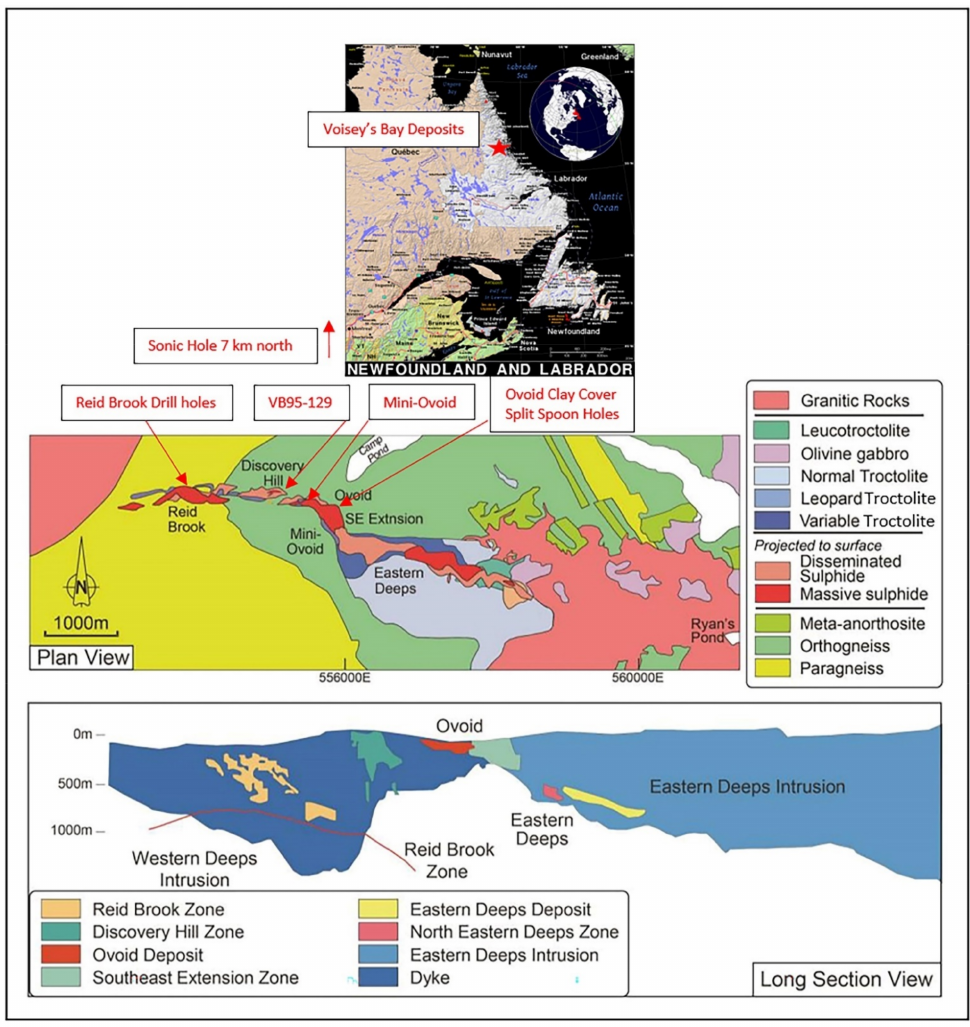
Figure 1. Plan view and long section of the Voisey’s Bay deposits and associated intrusion (from [10]) with locations of the six sample sites in this study. Inset map shows the location of Voisey’s Bay deposits in Labrador,